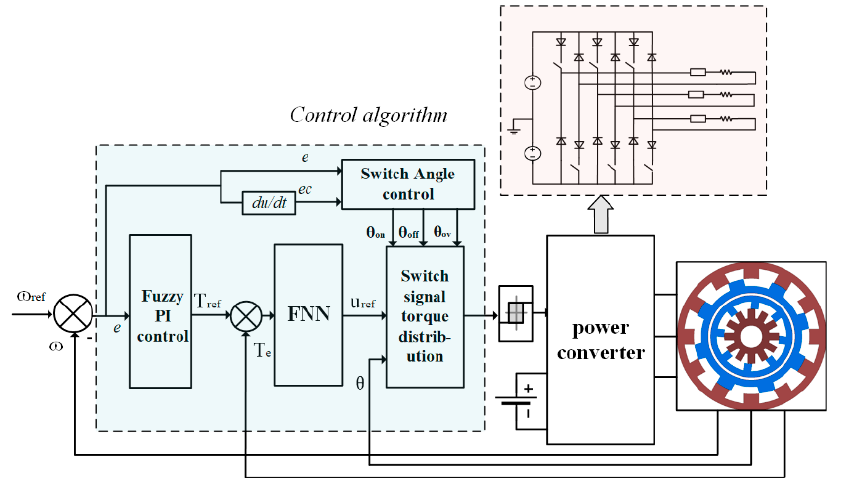
Figure 7. DSRM control system based on FNN.